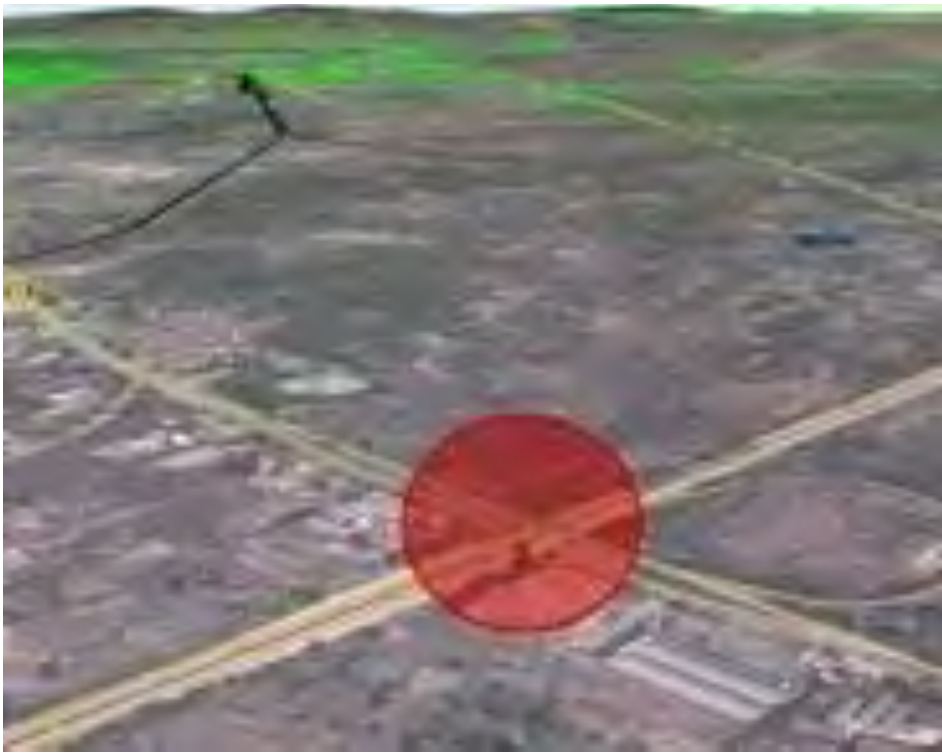
Figures 12: Accident spot 1 near Shedung Pune